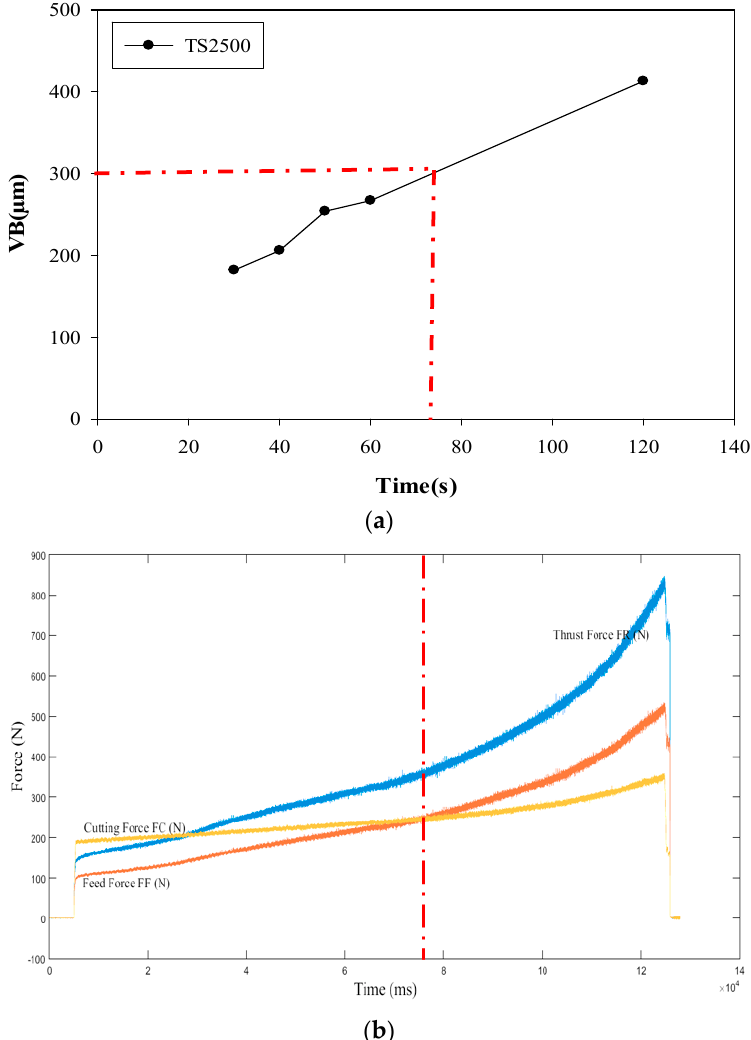
Figure 13. ( a ) Flank wear (VB); ( b ) cutting force profile of insert TS2500 for 120 s of cutting time.